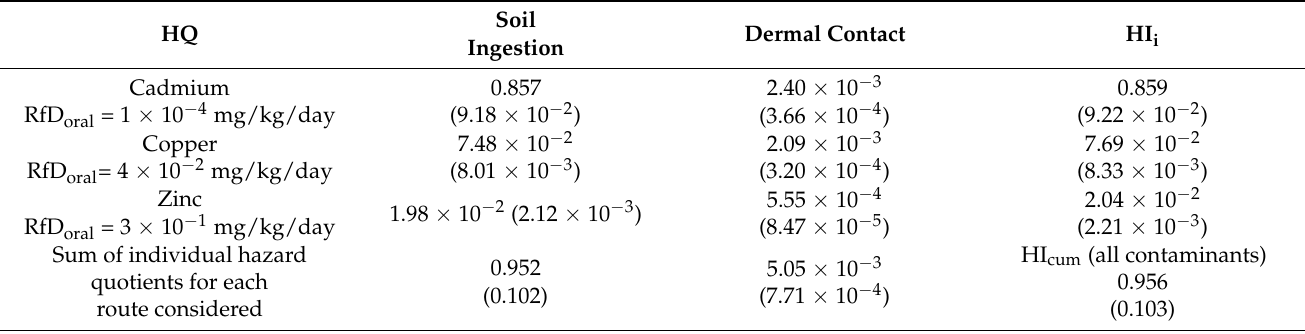
Table 5. Summary of Hazard Quotient (HQ) for non-carcinogenic risk calculated for each contaminant and for direct exposure routes, for children and adults receptor (in brackets values for adult when different). The individual (HI i ) and cumulative (HI cum ) Hazard Index are also